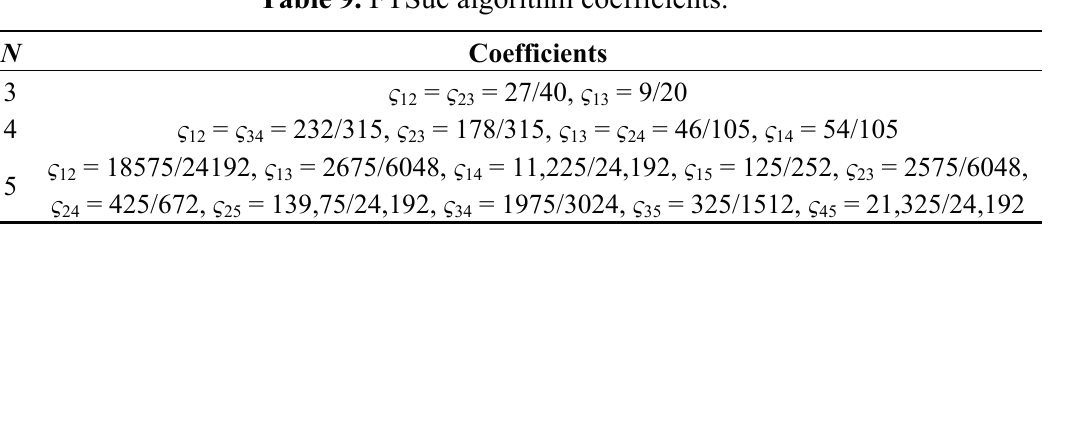
Table 9. FTSuc algorithm